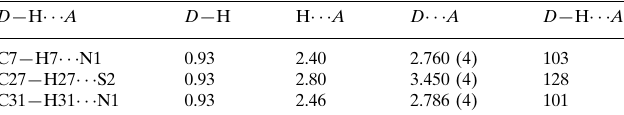
Hydrogen-bond geometry (A˚ , (cid:1)